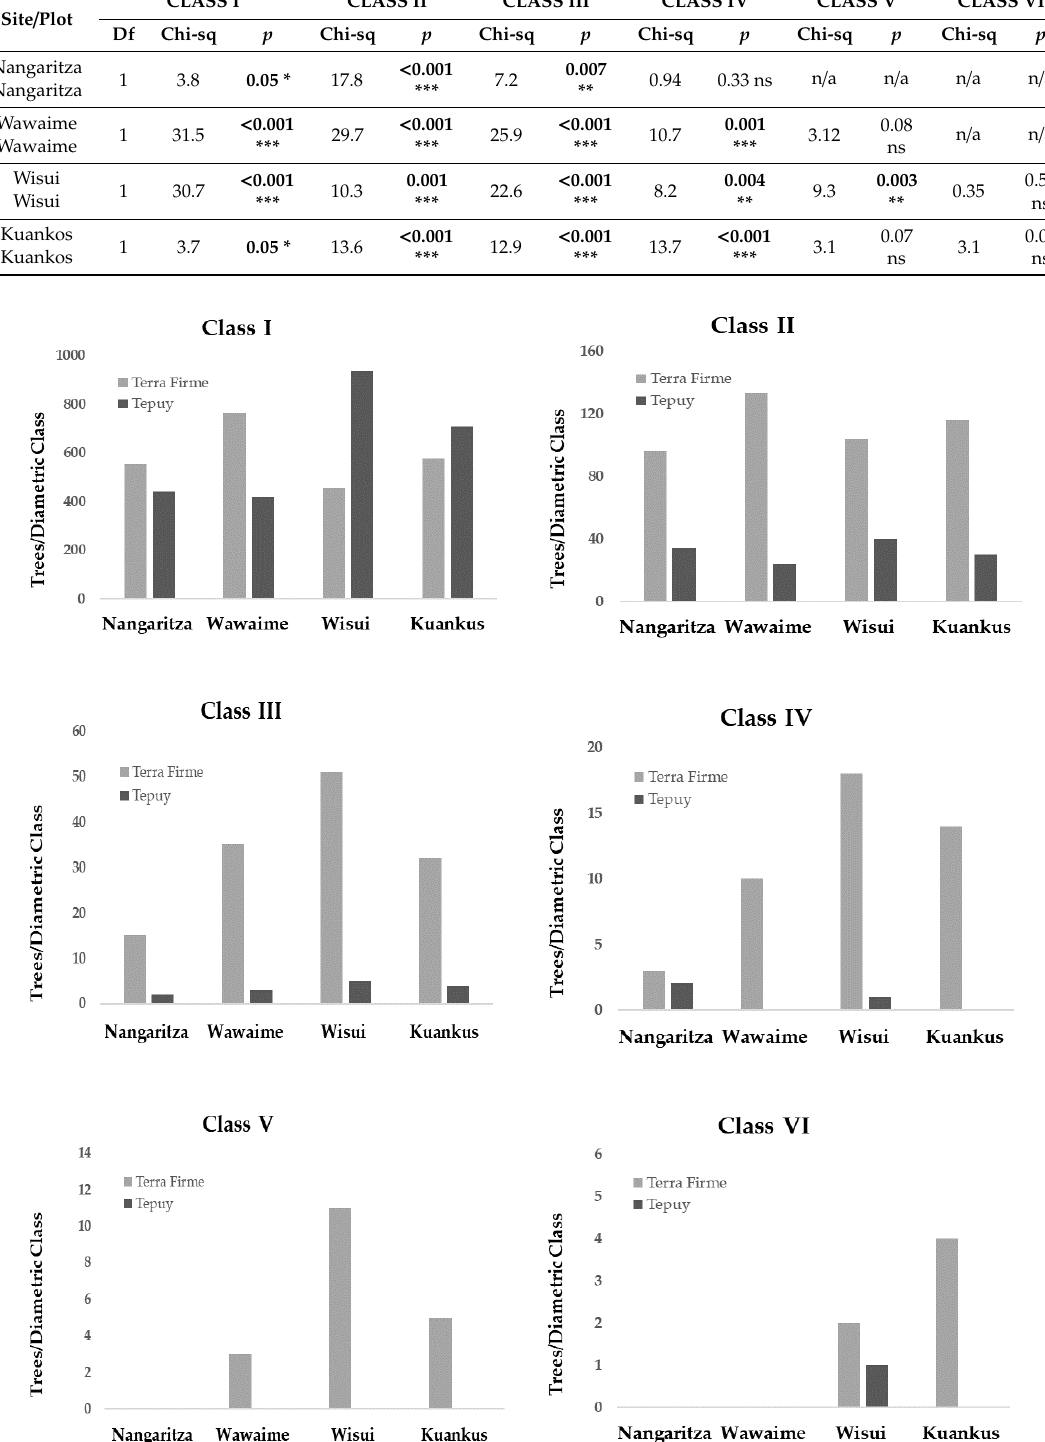
Table 4. Comparison of the number of individuals in the determined diametric classes, in each locality and in each type of forest, bold values show significant di ff erences.